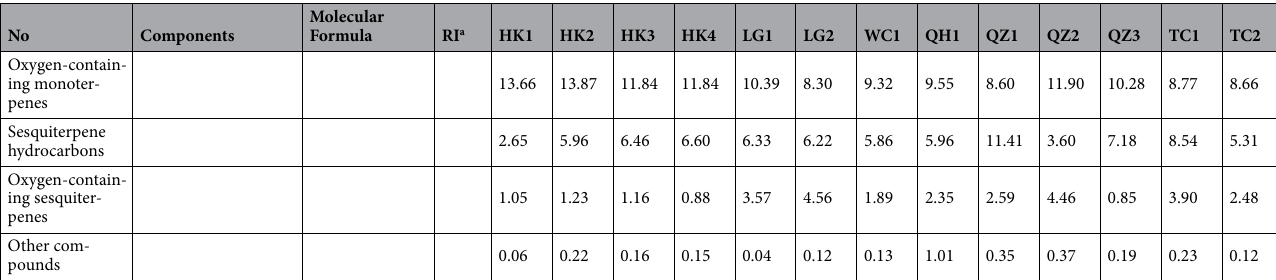
Table 2. Chemical components and contents (%) of EOs of C. lansium seeds. a RI: calculated retention index; –: Not detected.